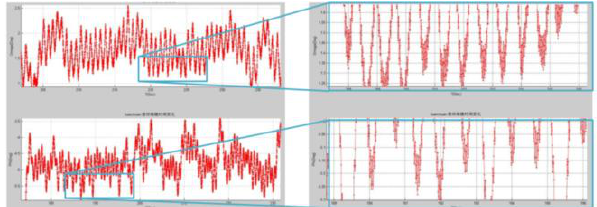
Figure 21 scanning data of a riverbank (lamp posts in Red ellipse) By amplifying and comparing the data recorded by INS on two different helicopters, we can safely conclude that vibration difference gives rise to difference in scanning accuracy. In Figure 22, INS gesture data record a 1.5Hz, 1-degree low- frequency vibration on the two horizontal axes (Omiga, Phi) of the gasoline helicopter. If we amplify the graph, we can see that this low-frequency vibration is loaded with another 24Hz, 0.15- degree vibration (Fig. 23). In comparison, a turbine-shaft helicopter produces only 16Hz, 0.1-degree vibration on the two horizontal axes (Fig. 24). On vertical axis (Kappa), the gasoline helicopter produces a 24Hz, 0.2-degree vibration, while a turbine-shaft helicopter produces only 16Hz, 0.02-degree vibration(Fig.25).